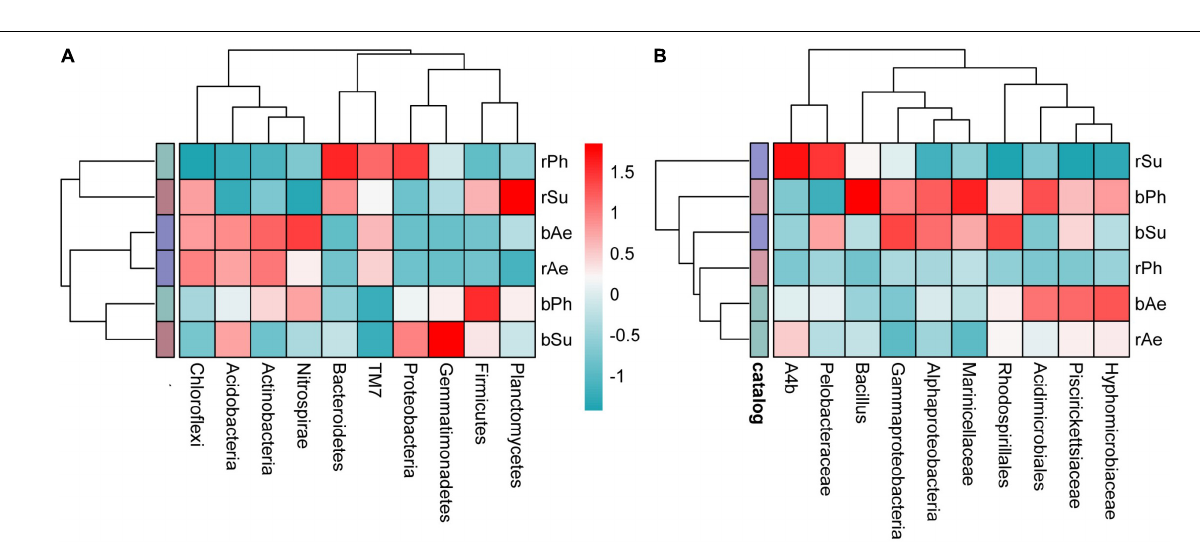
FIGURE 4 | Heatmap of the top 10 bacterial phyla (A) and genera (B) in the rhizosphere and bulk soil of different halophytes. The range from red to blue represents the relative abundance from high to low.